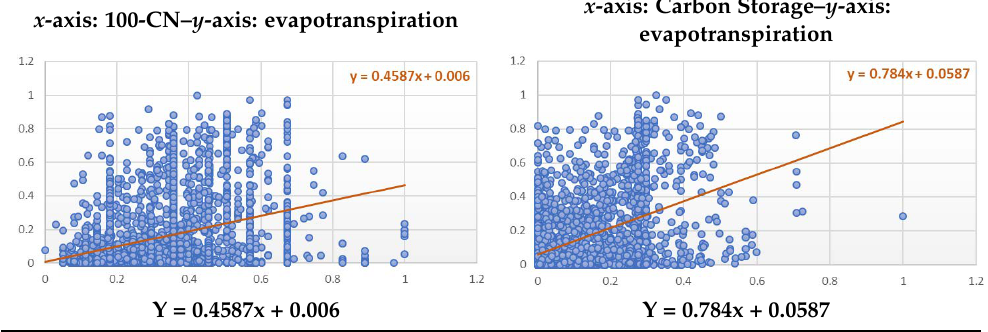
x -axis: Carbon Storage– y